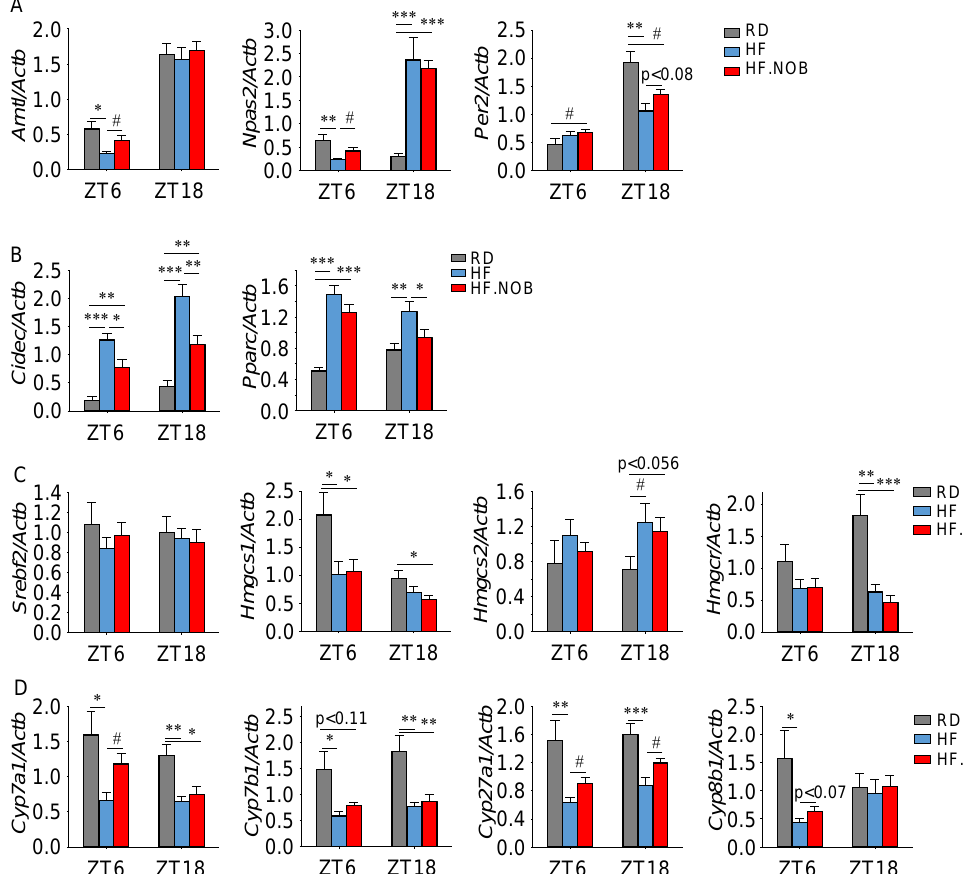
Figure 3. Nobiletin (NOB) reprograms the expression of circadian and lipid regulatory genes. ( A ) Core clock gene expression levels in the liver were analyzed by qPCR ( n = 7–11). ( B ) Fatty acid and lipid metabolism related genes in the liver were analyzed by qPCR ( n = 7–11) ( C ) Cholesterol biosynthesis related genes in